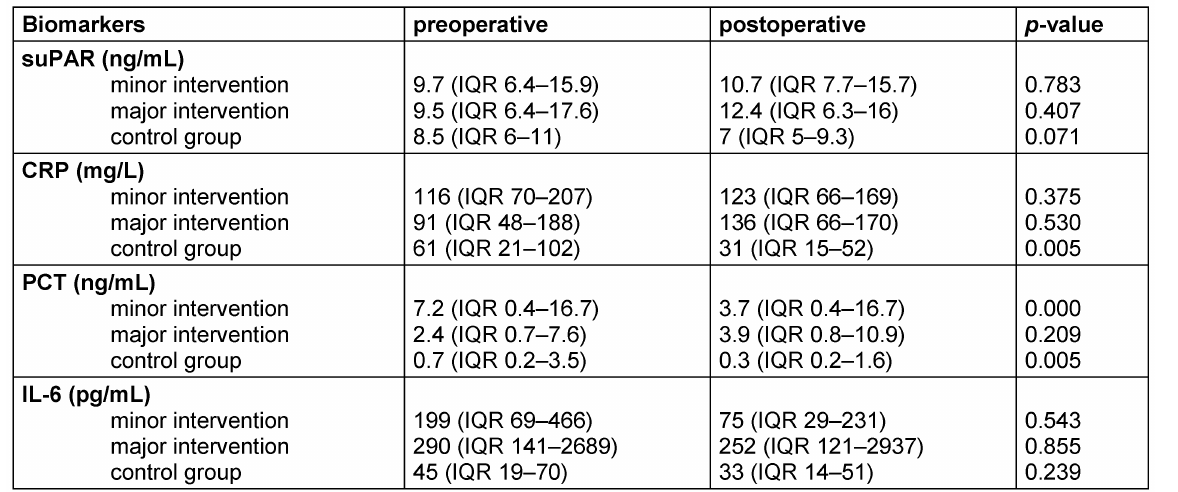
Table 4: Pre- and postoperative levels of biomarkers based on type of surgical intervention. SuPAR, CRP, PCT, and IL-6 levels (median and IQR) pre- and postoperative andp-values displayed for subgroups receiving minor (n=22), major surgical interventions (n=24) and control group